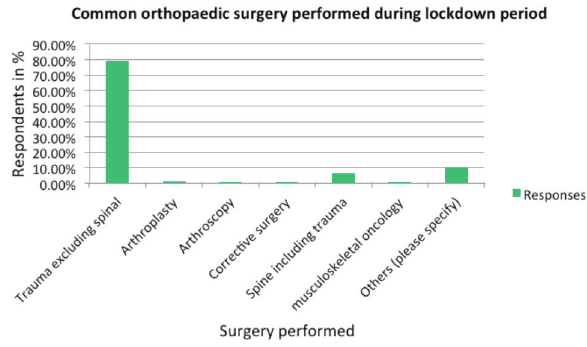
Common orthopaedic surgery performed during Fig. 2: lockdown